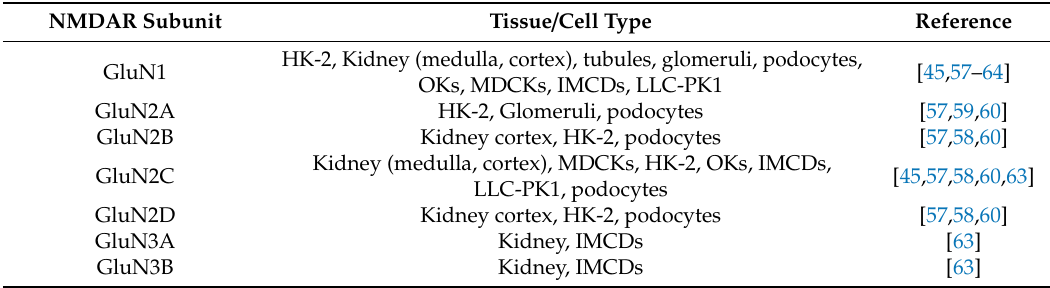
Table 1. Synopsis of the expression of various subunits of the NMDAR in di ff erent regions of the kidney. HK-2, human proximal tubular cells; OKs, opossum kidney cells; MDCKs, Madin-Darby canine